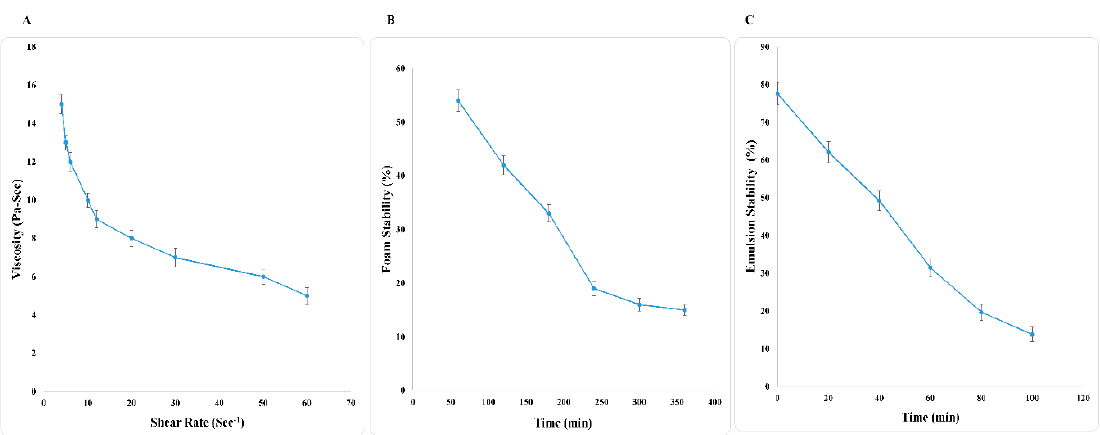
Table 5. Functional attributes of flaxseed-derived-PSG-supplemented yoghurt.